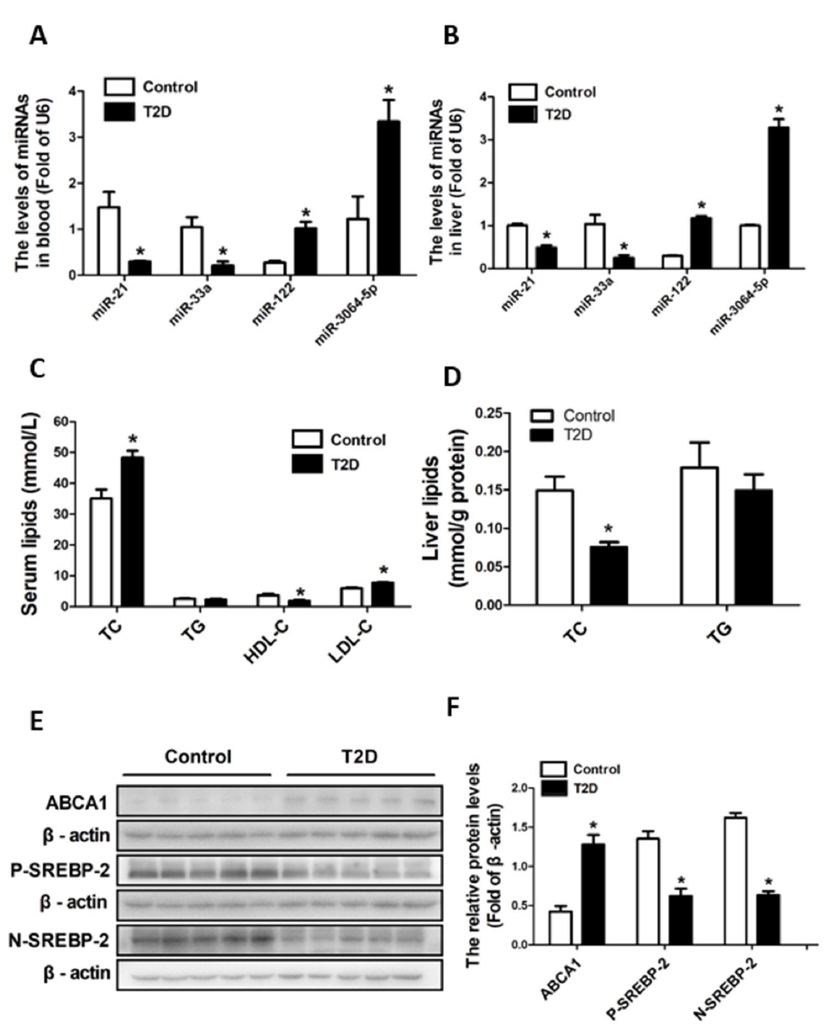
Figure 4. The miRNAs expression and lipid profiles in the blood and liver as well as the expression of key molecules for the synthesis and efflux of cholesterol in the liver. The relative expressions of miR ‐ 21, miR ‐ 33a, miR ‐ 122, and miR ‐ 3064 ‐ 5p in the blood ( A ) and liver ( B ) were detected by using real ‐ time fluorescent quantitative PCR. The levels of TC, TG, HDL ‐ C, and LDL ‐ C in the serum ( C ), and TC and TG in the liver ( D ) were determined by using commercial kits. The protein expressions of Abca1 and Srebp ‐ 2 in liver tissues were determined by western blotting ( E , F ). Data were statisti ‐ cally analyzed using the independent sample t ‐ test in the SPSS 20.0 software. Results represent means ± S.D. of the samples from five ( n = 5) mice in each group. *: p < 0.05 vs. control.